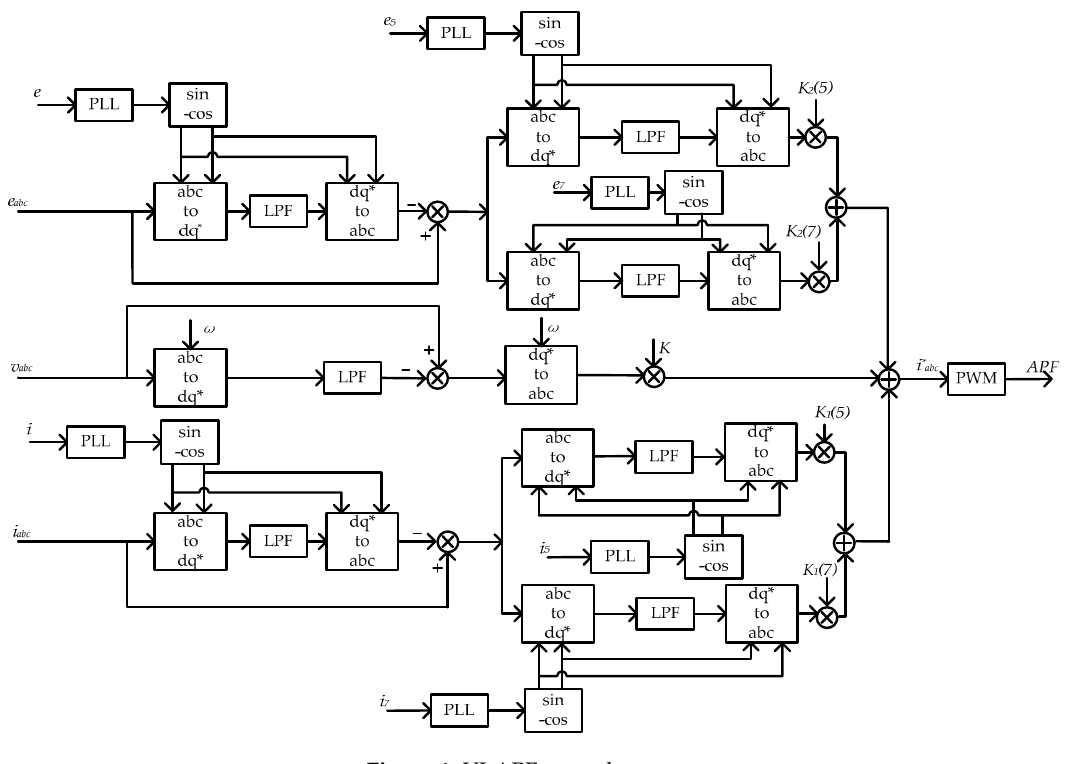
Figure 4. VI-APF control strategy.